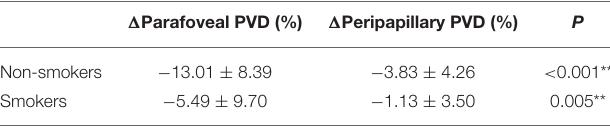
TABLE 4 | Comparisons of retinal microvascular reactivity to VM-IV between parafoveal region and peripapillary region.